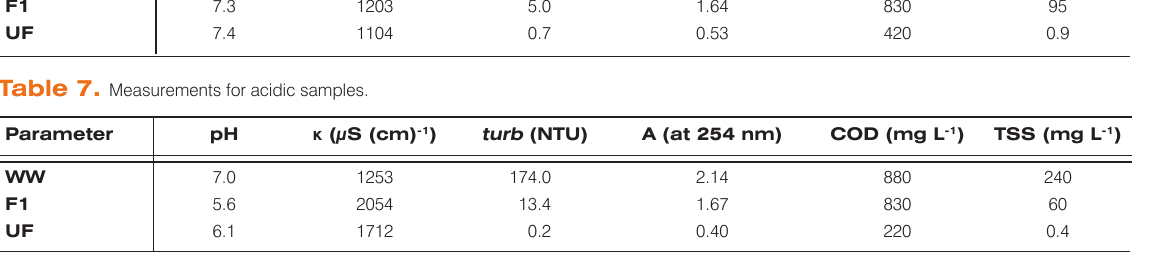
Table 8. Measurements for alkaline samples.